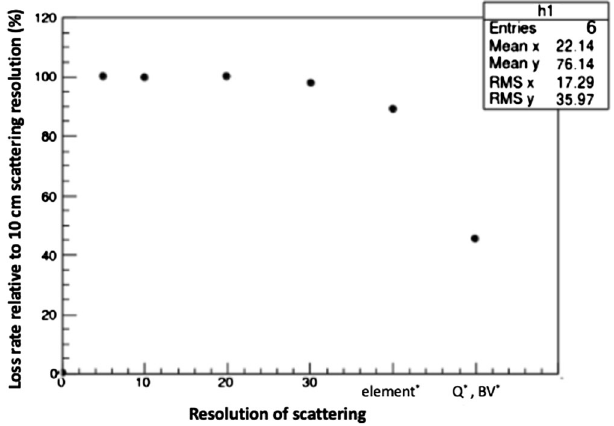
IP).FIG. 3. The percentage of loss in the drift where we placed our DS relative to the highest resolution (5 cm) as a function of scattering resolution in cm (the labels element*, Q (cid:2) and BV (cid:2) correspond to scattering only at the beginning of each element, quadrupole, or bending magnet,